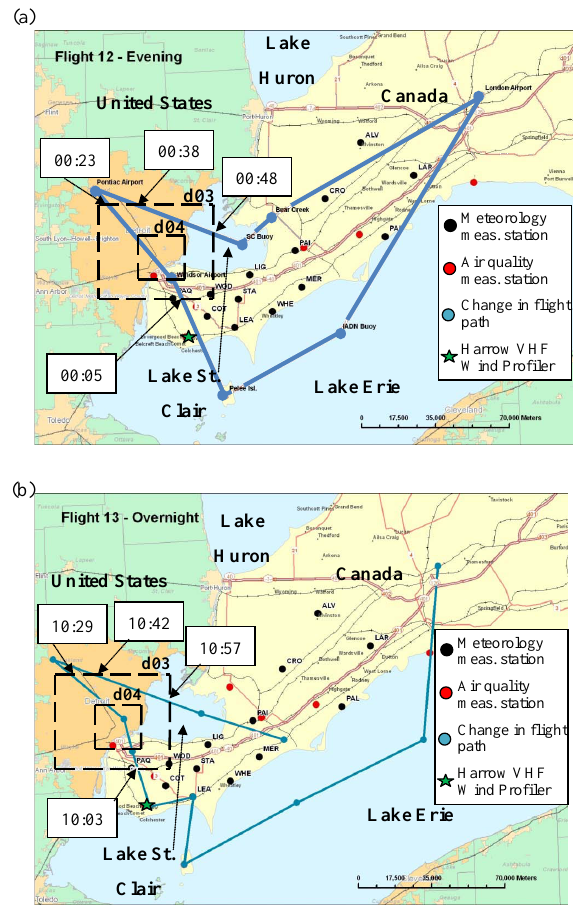
Fig. 2. The approximate flight paths of Flight #12 (a) and #13 (b) during BAQS-Met 2007, depicted by the blue line. The third (d03) and fourth (d04) model grid domains are outlined in dashed black lines with boxes indicating the approximate UTC time (4 July 2007 (a) , 7 July 2007 (b) ) upon entering and exiting the d03 do- main. Adapted with permission from a figure by Julie Narayan, Environment